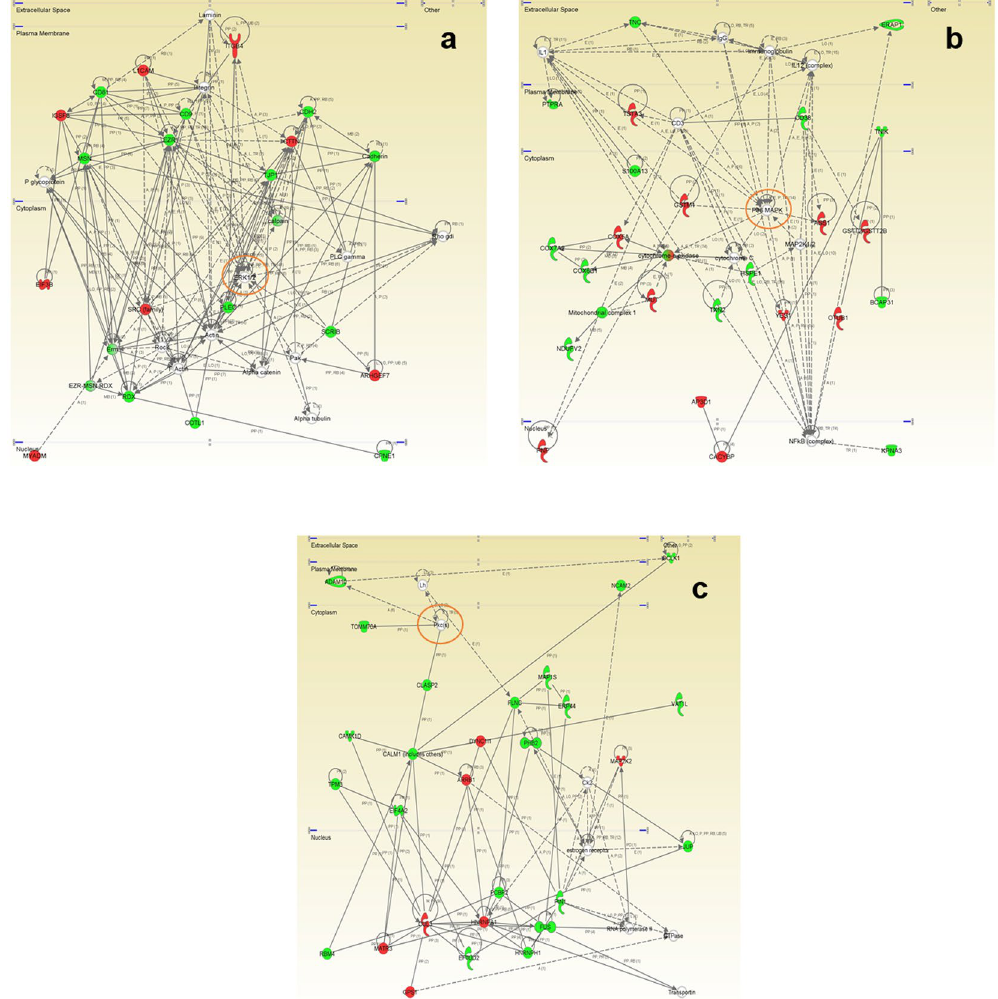
Figure 3. High-scoring protein interactome maps for differentially expressed proteins in the OB during AD progression. Visual representation of the relationships between differential expressed proteins and functional interactors in initial ( a ), intermediate ( b ), and advanced AD stages ( c ). Dysregulated proteins are highlighted in red (up-regulated) and green (down-regulated) for each stage. Continuous and discontinuous lines represent direct and indirect interactions respectively. The complete legend including main features, molecule shapes, and relationships is found in